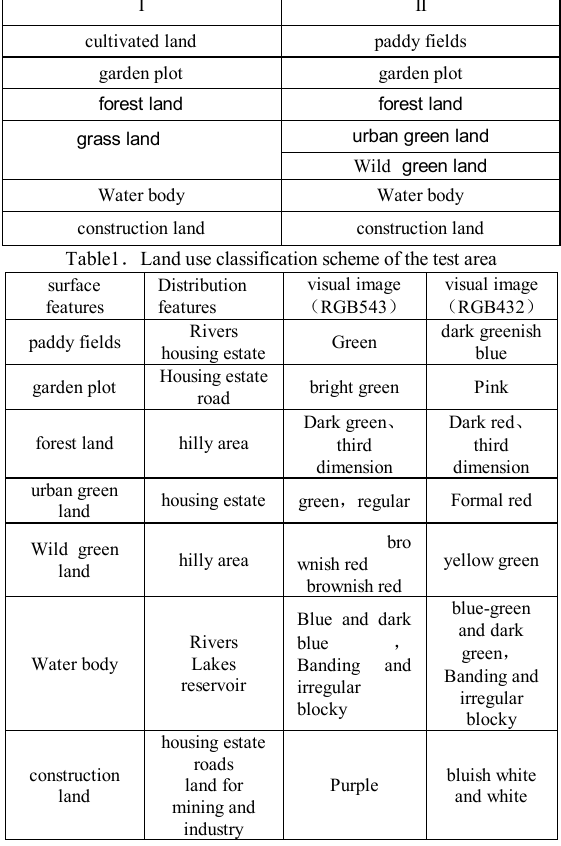
Table2. Visual characteristics of the Land use of the test area